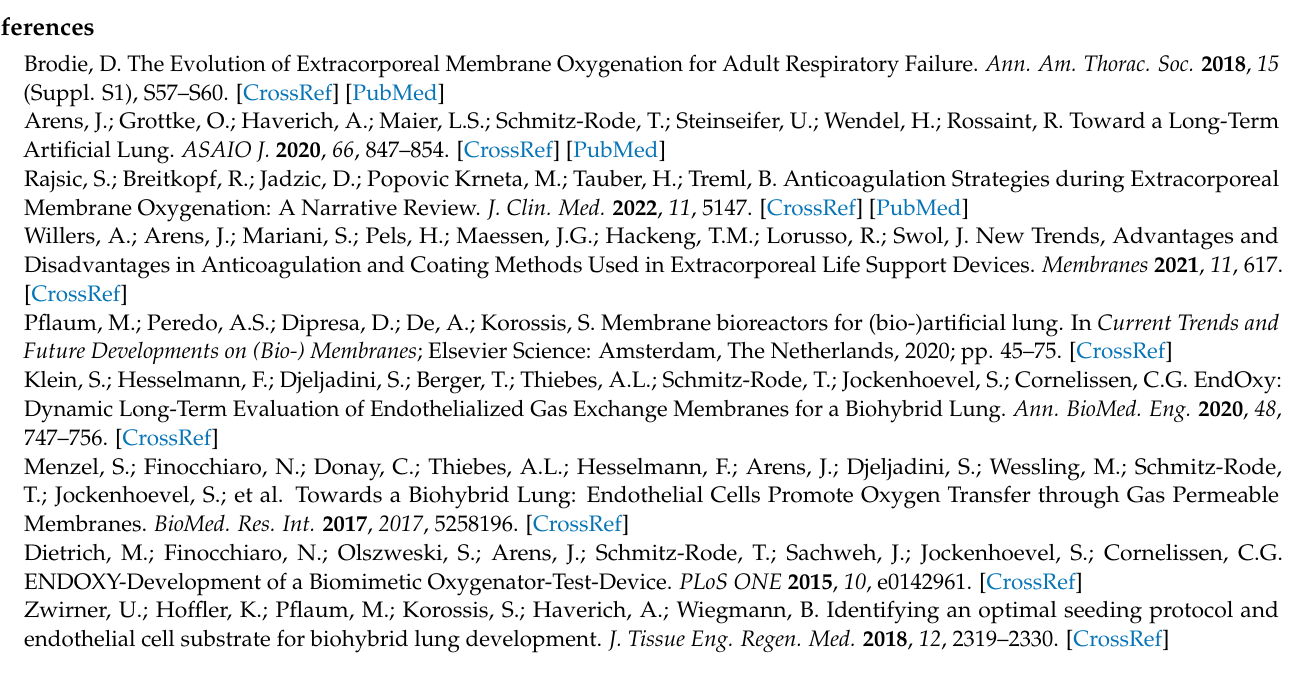
temperature. Figure S1: Representative picture of a spray pattern. Following parameters have been used: high flow rate, working distance—9 cm. Figure S2: Representative pictures of